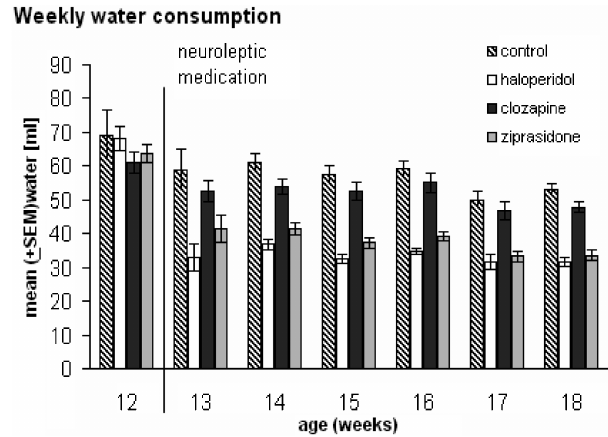
Figure 3 - Weekly food consumption based on 100 g BW of male Wistar rats: control (n = 19) and animals treated with haloperidol, clozapine, or ziprasidone (n = 20 for all groups). All animals showed decreased food consumption from week 11 to week 18 with no differences before medication. Animals under haloperidol medication ate less than the control and clozapine groups after 1 week of application. Ziprasidone- treated rats ate less than the controls after 3 week of medication. We found no differences between the control and clozapine groups with p # 0.008 considered significant.